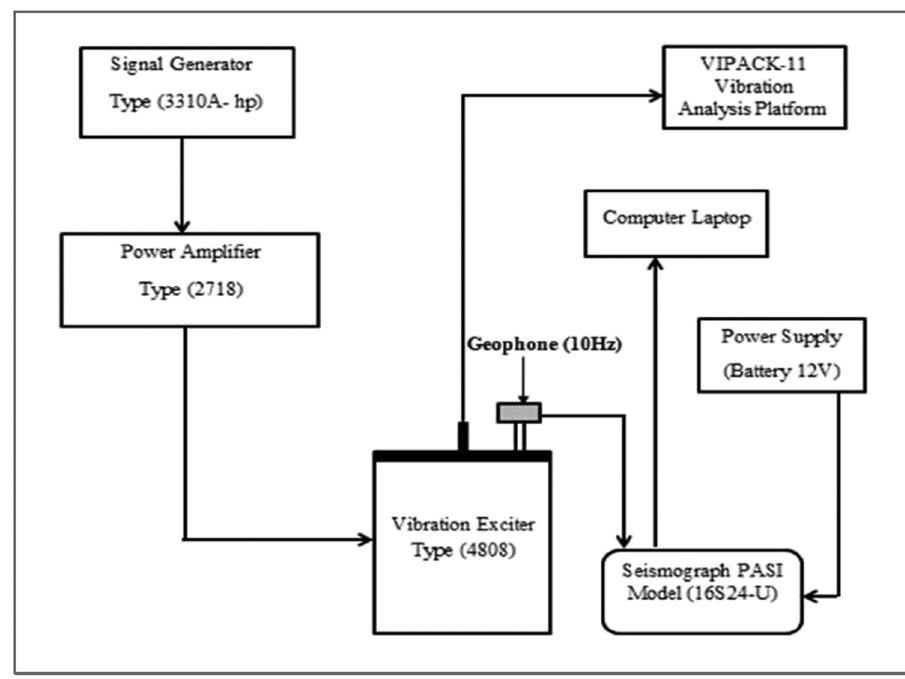
Figure 3: Schematic diagram of the geophone calibration.